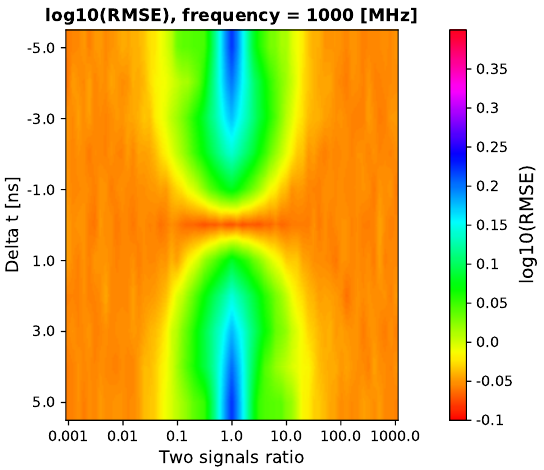
Figure 6. The 2-dimensional distribution of arrival time di ff erence and signal ratio of two signals for sampling frequency 1000